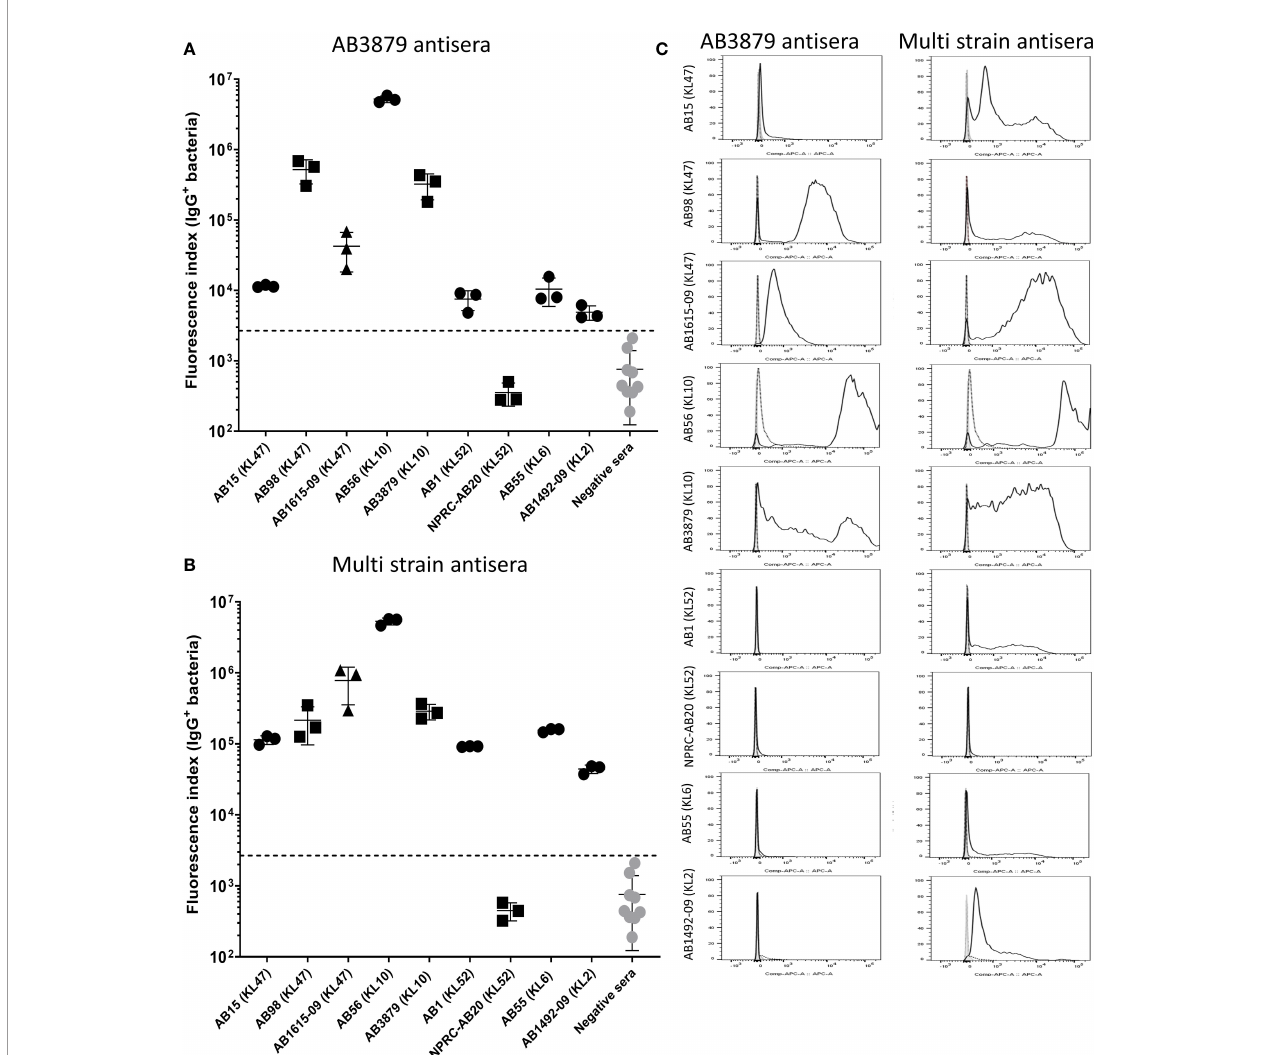
FIGURE 3 | IgG recognition of a panel of nine A. baumannii isolates by mouse antisera generated against immunization with one strain or sequentially with three strains. (A) Mouse AB3879 antisera and (B) multi strain (AB3879+AB1492-09+AB1615-09) antisera IgG binding to the surface of A. baumannii isolates as measured by fl ow cytometry. The nine isolates are grouped in order of their respective capsule serotypes and are indicated in brackets on the X-axis. Round, square and triangle isolates belong to the ST2, ST215 and ST164 MLST type respectively. The Y axis shows the proportion of IgG positive bacteria multiplied by the median fl uorescent intensity (MFI) of IgG positive population, in each of the nine A. baumannii isolates. (C) Representative histograms showing IgG binding of 1x10 6 CFU of the nine A. baumannii isolates to either AB3897 antisera (left panel) or multi strain antisera (right panel). Grey histogram represents bacteria labelled with 2 nd antibody only, black-dotted line represents bacteria incubated with sera from non-immunized mice and black solid line represents bacteria incubated with the respective sera (AB3879 antisera left panel and multi strain antisera right panel). The nine isolates and their respective KL class denoting the capsule serotypes are indicated alongside respective histograms. Dot plots represent triplicate values with lines indicating the mean values and the error bars indicate standard deviations (SDs) (n = 3). Representative data from two independent experiments is